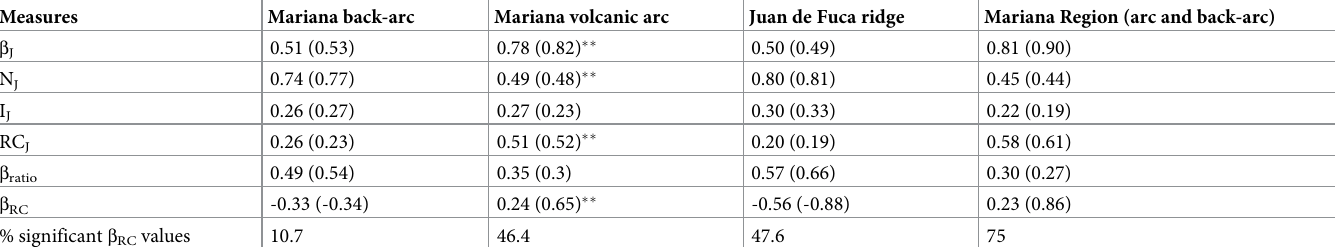
Table 4. Species diversity measures for the three study vent